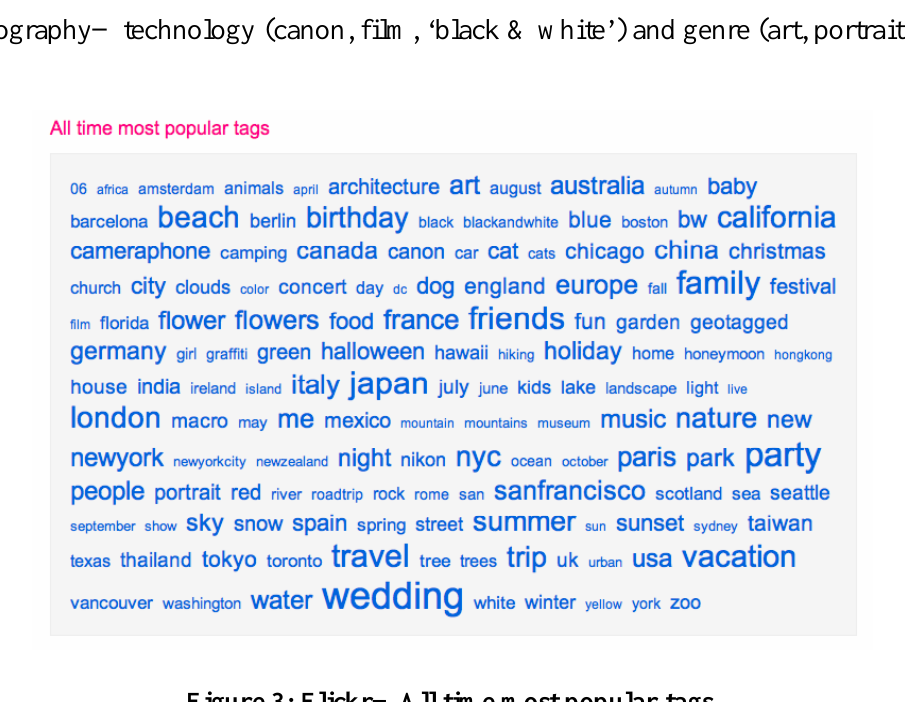
Figure 3: Flickr—All time most popular